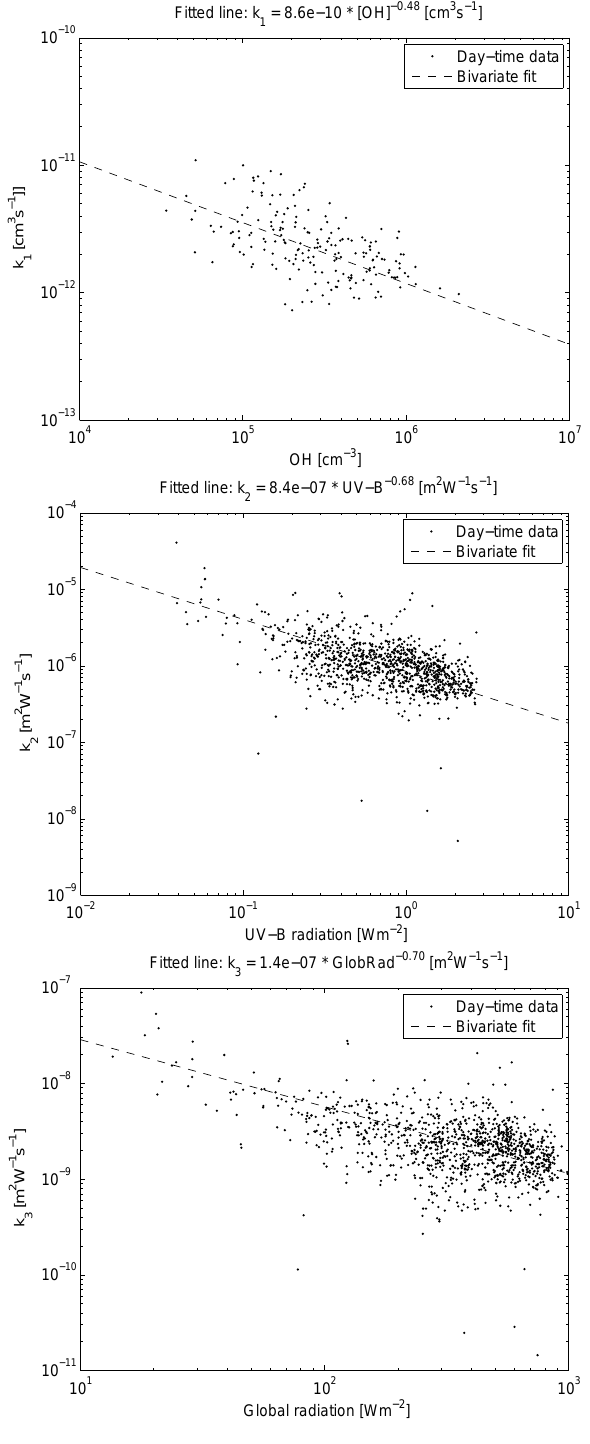
Fig. 2. The sulfuric acid proxy scaling factors, calculated from Eqs. 2–4 by replacing the left hand sides with the measured concentrations, during day-time for a) OH proxy, b) UV-B proxy and c) the proxy utilizing global radiation.